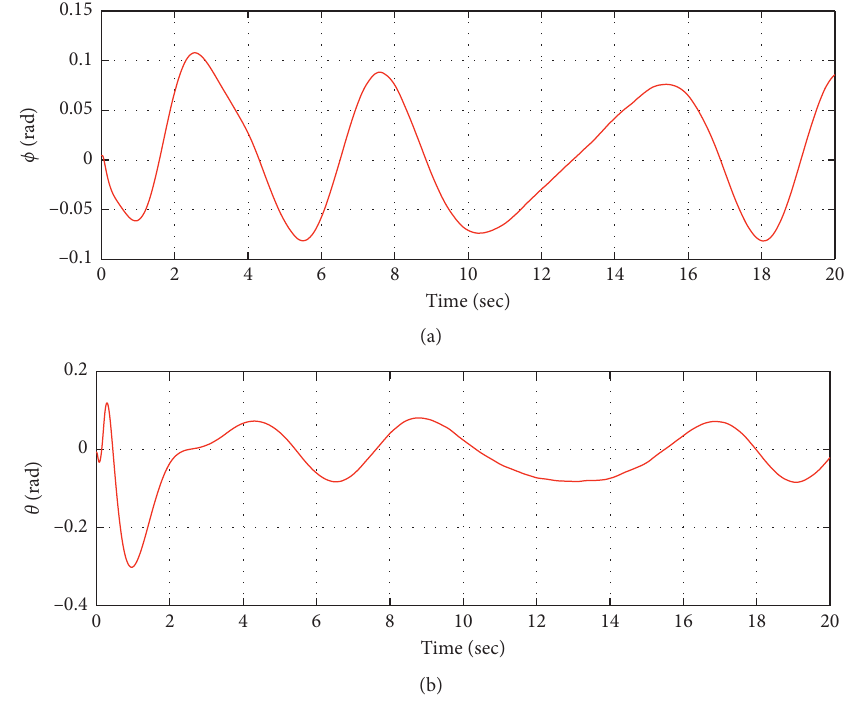
Figure 11: Change of roll and pitch angles.